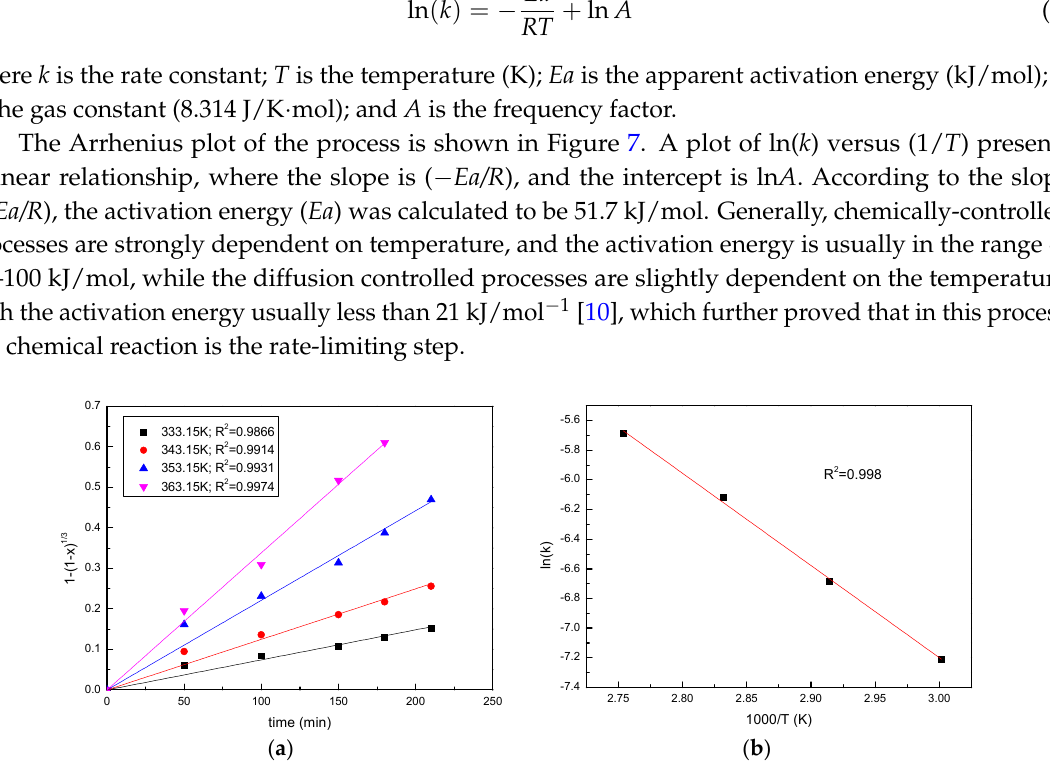
( b ) Figure 8. Analysis of reaction order with respect to sawdust/ore mass ratio ( a ) Plots of 1 − (1 − x ) 1/3 vs. time for manganese at various sawdust/ore mass ratios; ( b ) the determination of the reaction order with respect to the sawdust/ore mass ratio.